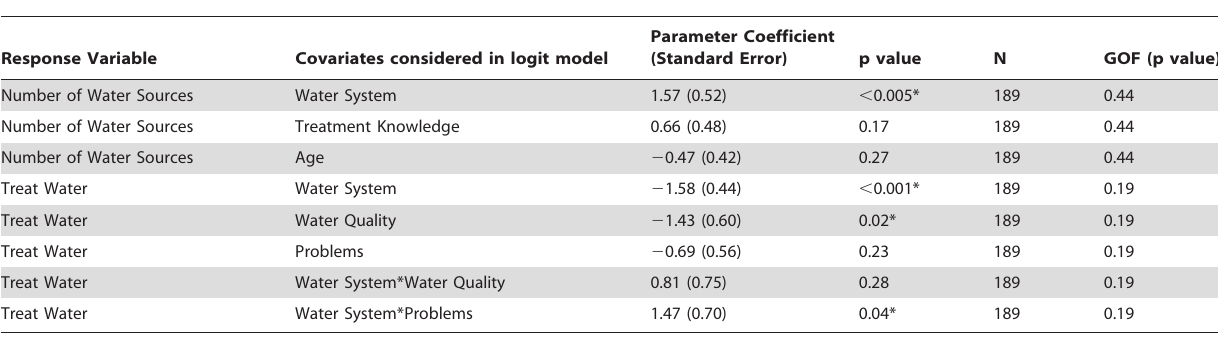
Table 3. Results for each statistical model predicting which factors are associated with household water management strategies.